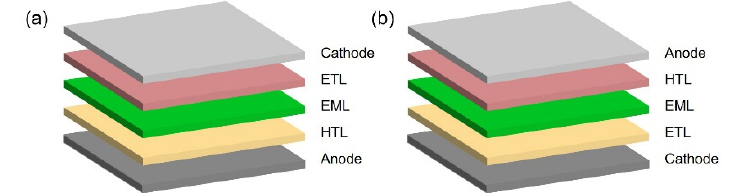
Figure 7. Schematic structures of LEDs with a ( a ) p-i-n and ( b ) n-i-p configuration.